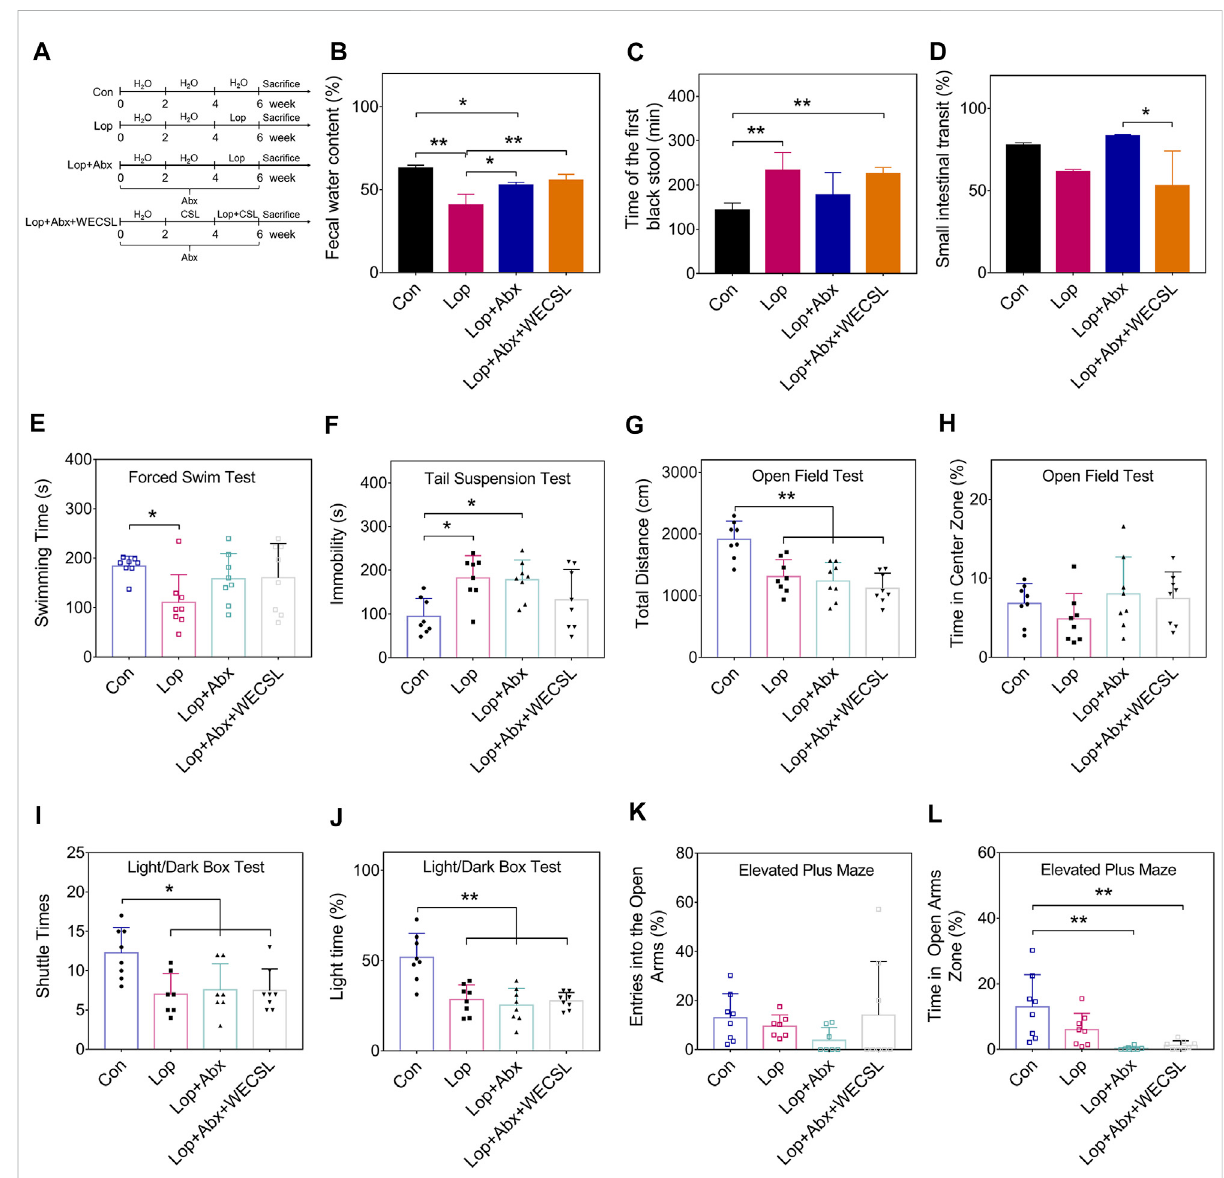
FIGURE 4 WECSL failed to improve constipation symptoms in mice following intestinal bacteria depletion. (A) Schematic diagram showing the animal experiments ( n = 8 per group). (B) Fecal water content. (C) Time of the fi rst black stool. (D) Small intestinal transit ratio. (E) Swimming time of mice in FST. (F) Immobility time of mice in TST. (G,H) The total distance traveled (G) and time stayed in the center zone (H) in the OFT. (I,J) Entries into the lightchamber (I) andtotaltimespentinthelightchamber (J) intheLDBT. (K,L) Entriesintoopenandclosedarms (K) andthetimespentinopen arms (L) in the EPM. Data are presented as mean ± SD ( n = 8 per group). * p < 0.05, ** p <